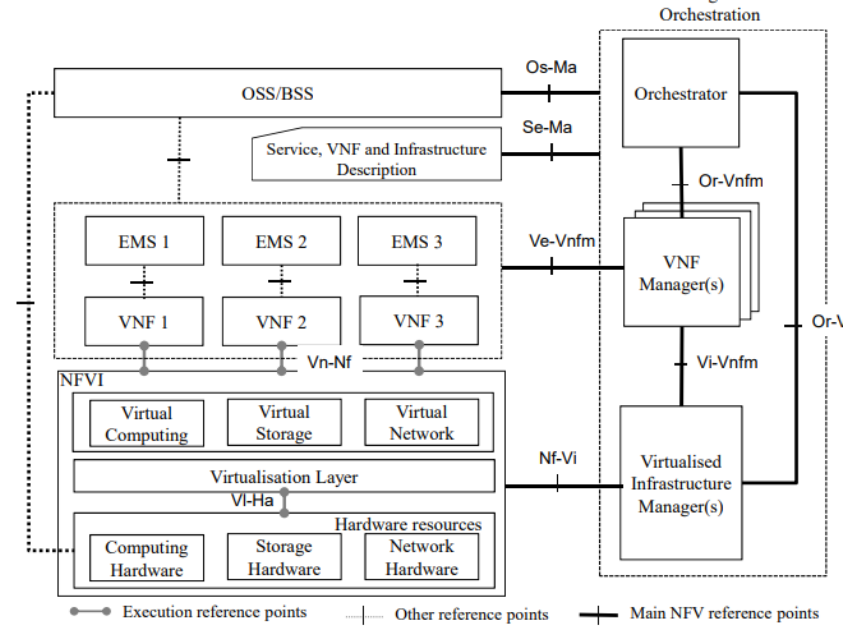
Figure 1. NFV reference architectural